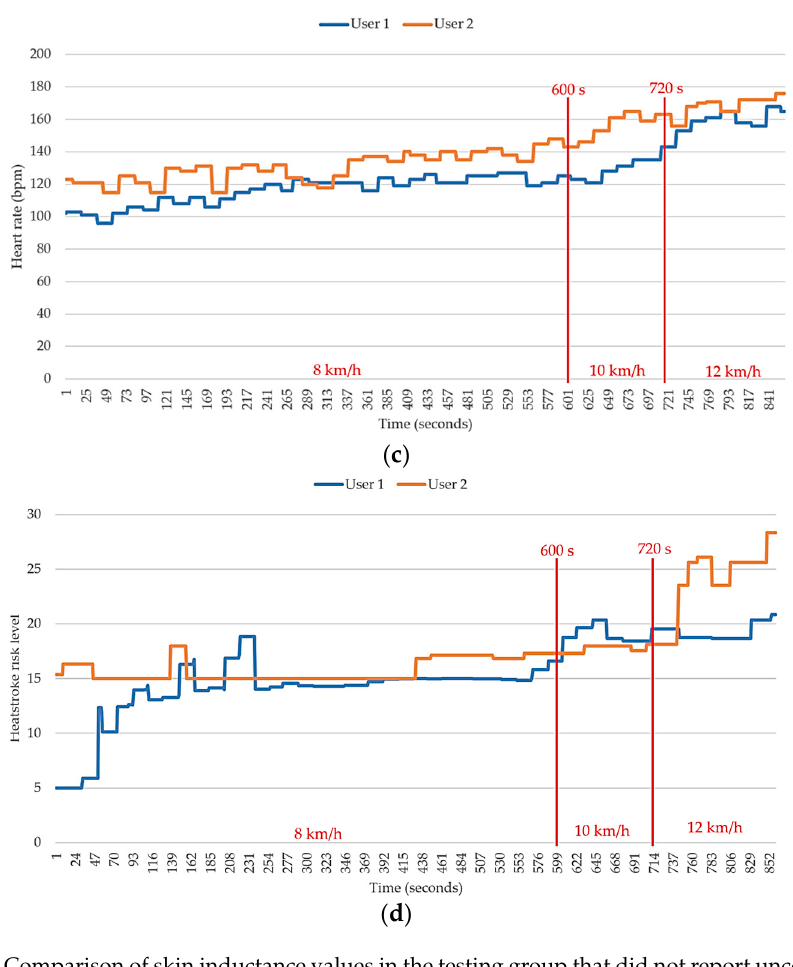
Figure 11. Comparison of skin inductance values in the testing group that did not report uncomfortable conditions (user 1 and 2). ( a ) Galvanic skin response (GSR); ( b ) body temperature; ( c ) heartbeat; and ( d ) heatstroke risk level.